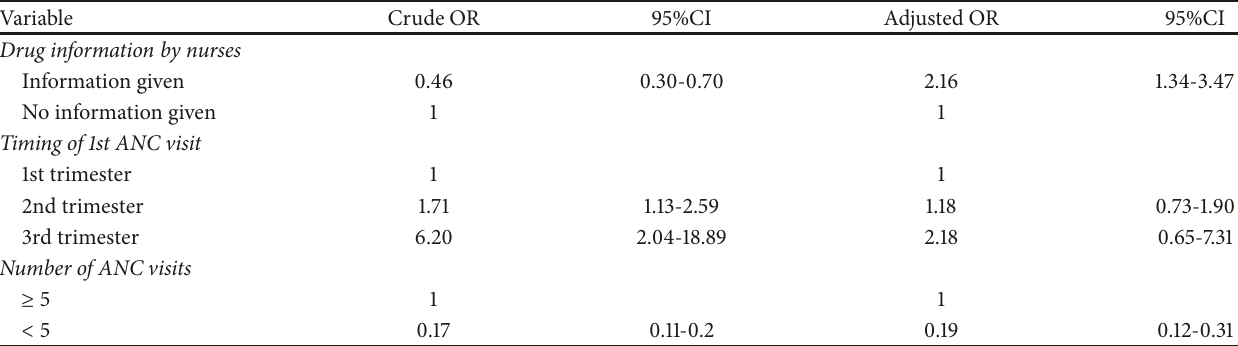
Table 4: Crude and adjusted associations between variables and uptake of